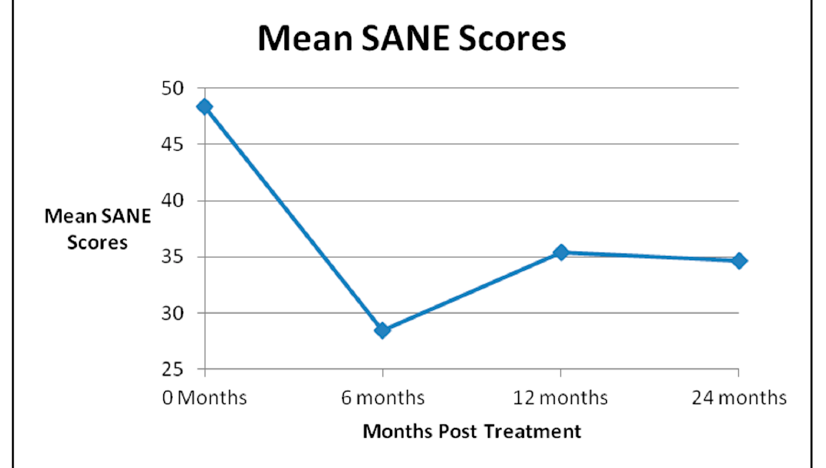
Figure 2. Single Assessment Numeric Evaluation (SANE)